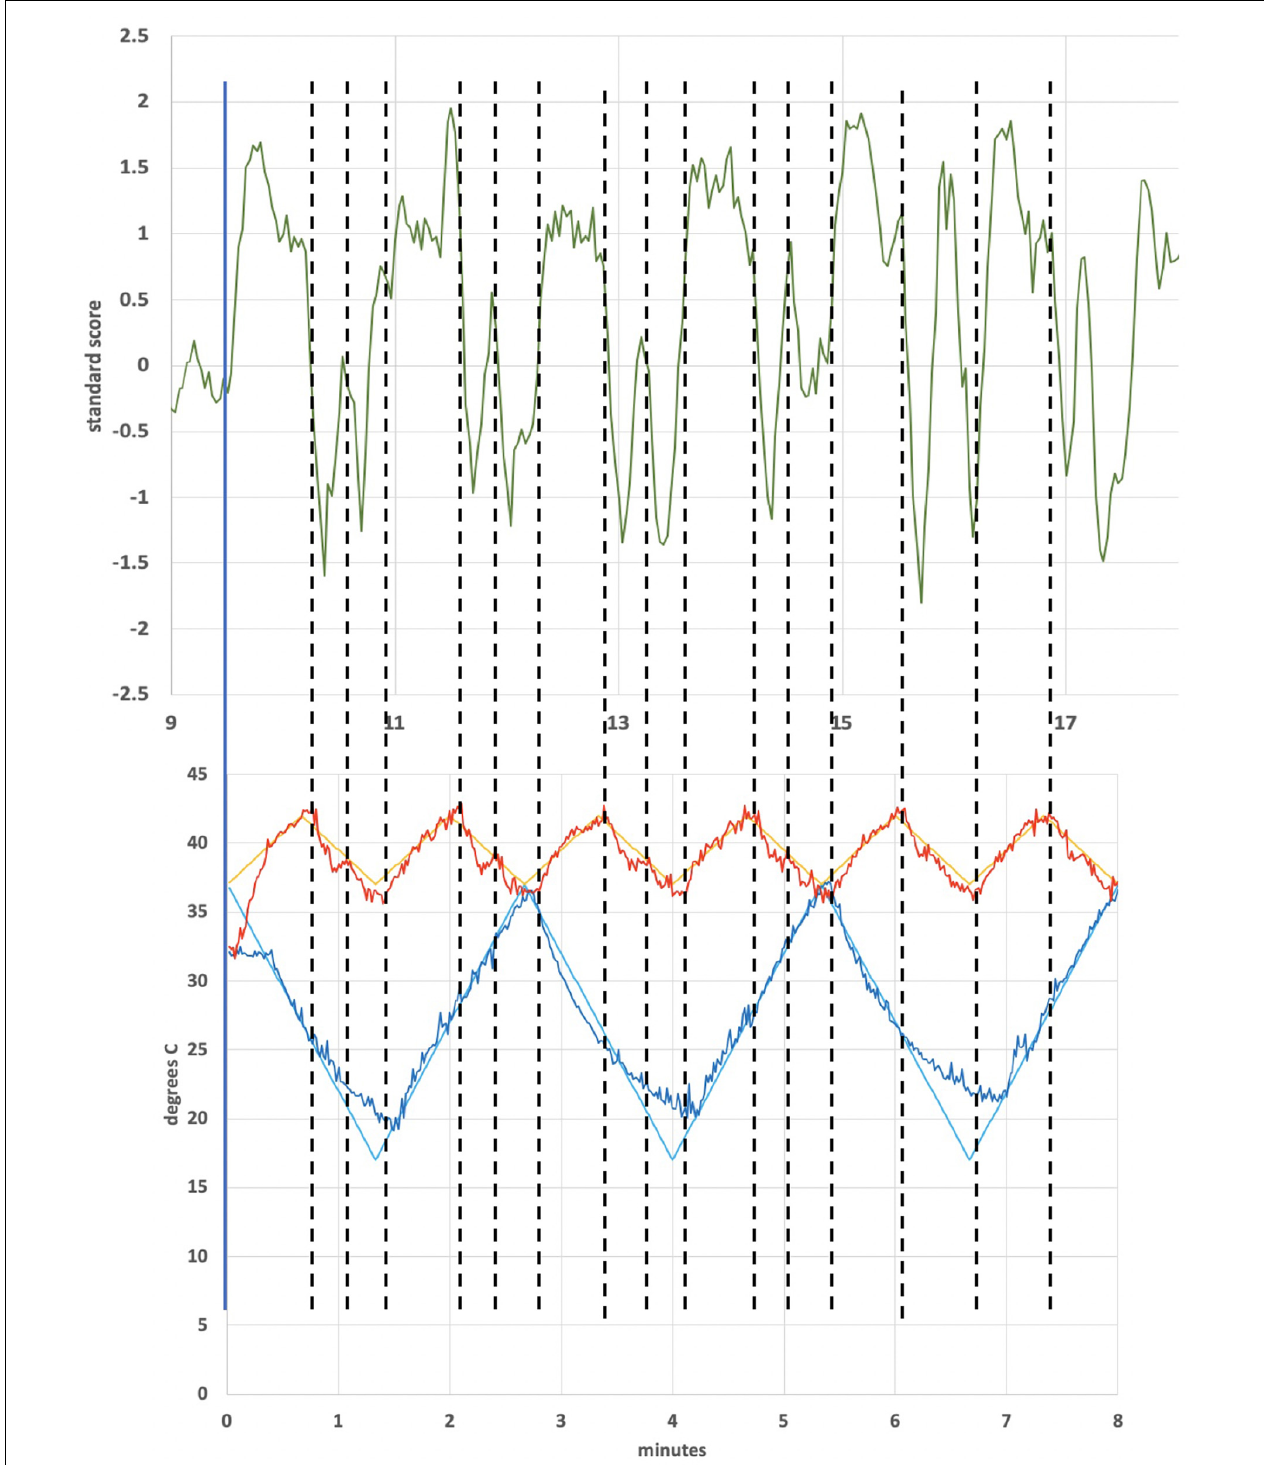
FIGURE 7 | Subject 1 warm waveform (first 6 cycles) and independent component localized in the operculum. The dotted lines match features in the warm waveform to the ICA trace. For example, the leftmost and third-from-left dotted line align with a high point on the warm waveform and a low point, respectively. These lines align with a trough in the ICA trace. The second-from-left dotted line was added to highlight a small, retrograde feature in the warm waveform that aligns with a peaked feature in the ICA.